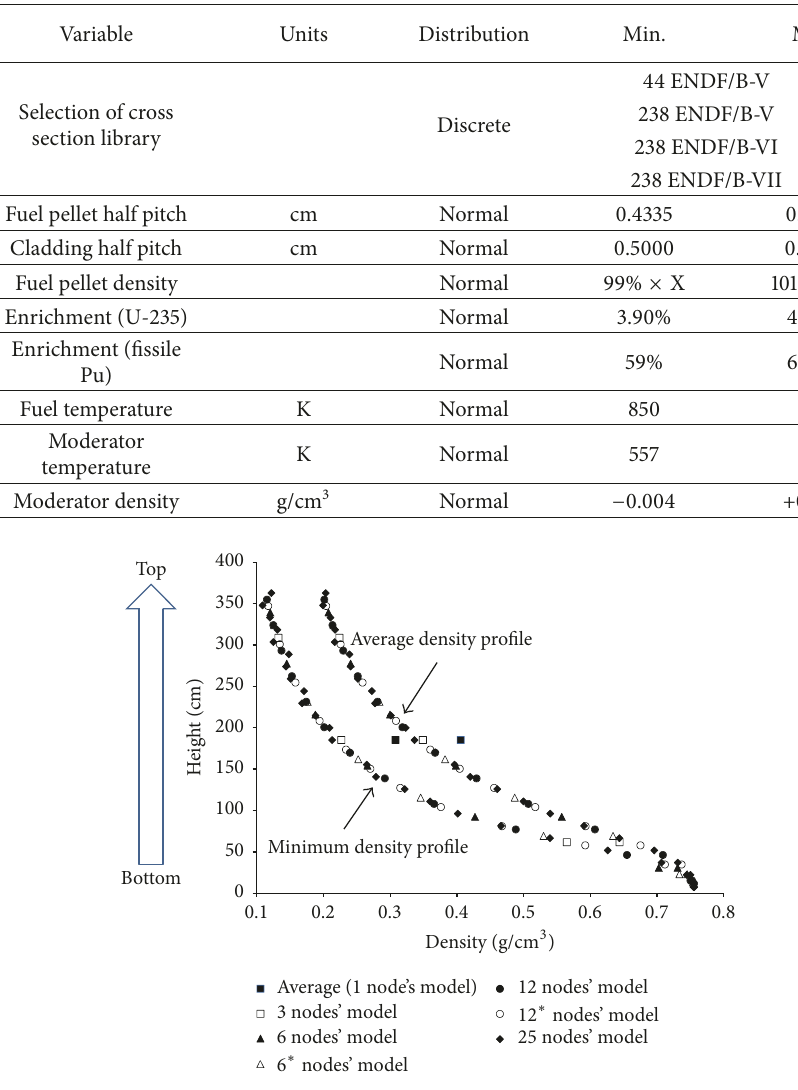
Figure 4: Distribution of moderator density values in